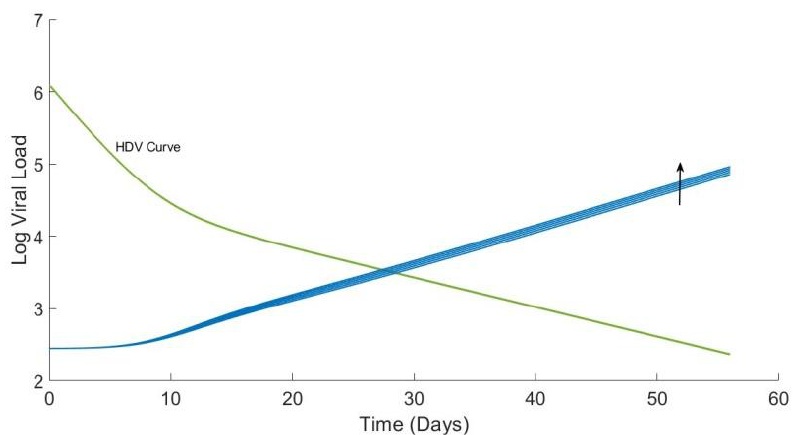
Figure A3. One-way sensitivity analysis on the impact of parameter κ on predicted HBV/HDV kinetics under anti-HDV treatment. Model parameters were set to D 0 = 1,202,260, B 0 = 282, n = 1.25, c = 0.47, g = 0.094, τ = 0.1, and ε = 0.97, with κ being set at κ = (23,523, 24,830, 26,137, 27,444, 28,751 ). The arrows depict the direction of increase of the parameter κ. HDV predicted kinetics were not affected by different n values.